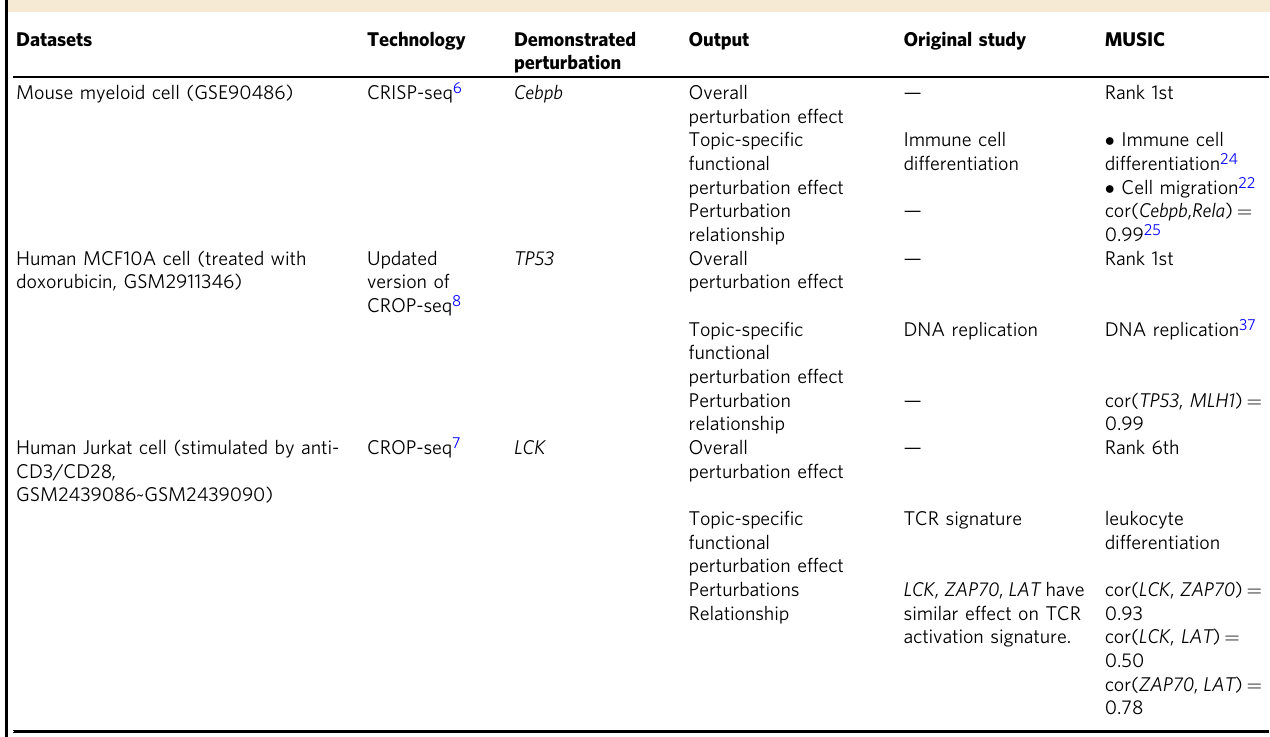
Table 3 Other representative analysis results of MUSIC